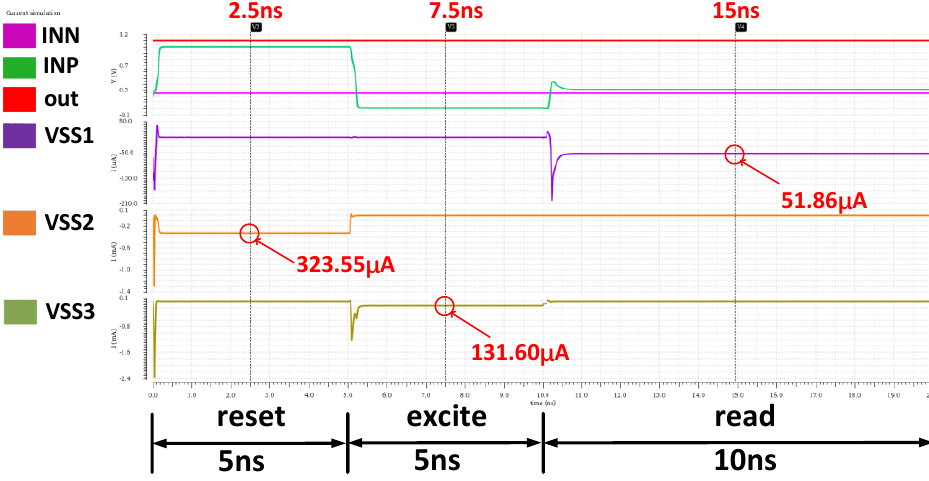
Figure 10. MTJ’s current simulation under reset, excite, and read operation modes. Table 3 lists the critical indicators of the three stochastic Ising spins. Table 3. Critical indicators of three stochastic Ising spins.